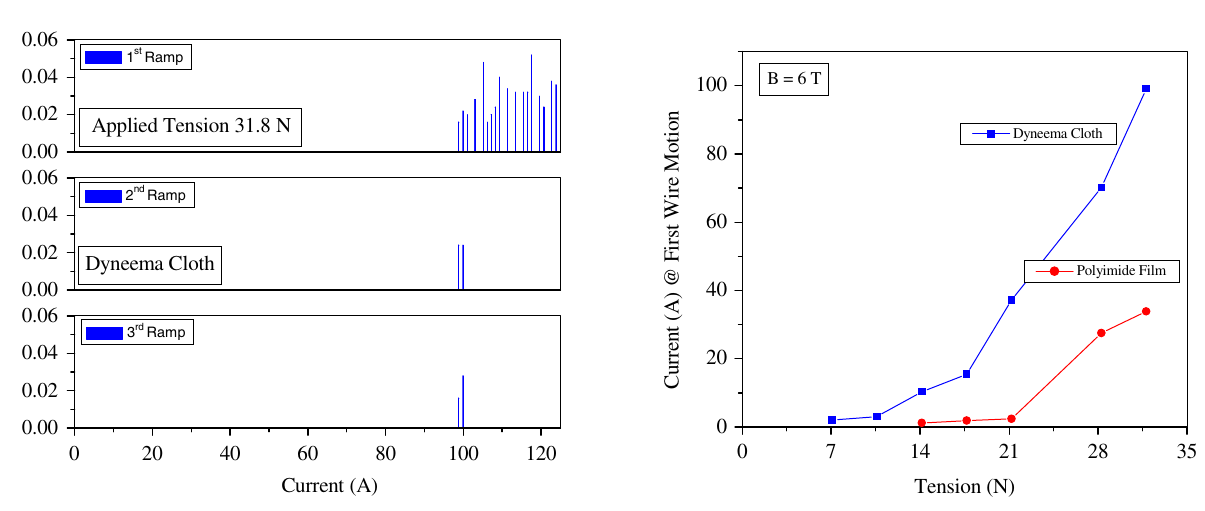
FIG. 5. (Color) Training effect as observed in the case of Dyneema cloth.